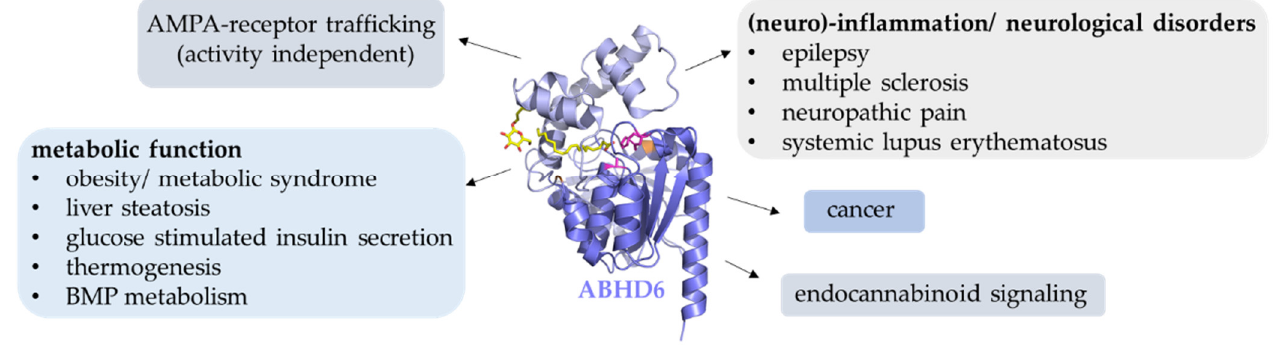
Figure 6. ABHD6 is involved in multiple (patho)-physiological processes. ABHD6 has been shown to be implicated in various (patho)-physiological processes, including lipid degradation, lipid signaling, inflammation, obesity, and cancer.